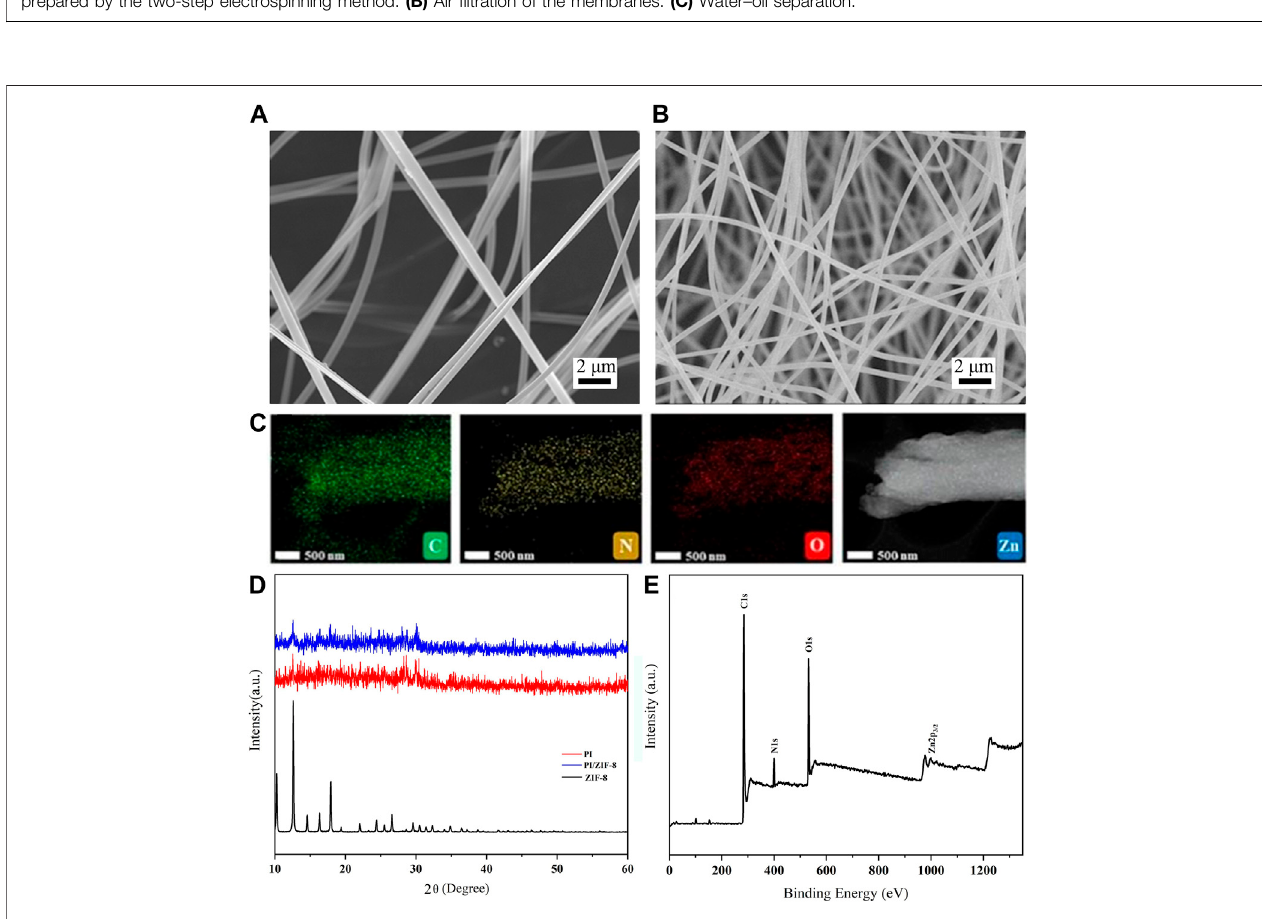
FIGURE 2 | Scanning electron micrographs of the PI-ZIF nano fi bers (A) PI and (B) ZIF-8-3/PI. (C) C, N, O, and Zn element distribution of ZIF-8/PI nano fi bers. (D) X-ray diffraction patterns of the ZIF-8, PI, and ZIF-8-3/PI nano fi ber membranes. (E) X-ray photoelectron spectroscopy images of the ZIF-8-3/PI nano fi ber membranes.